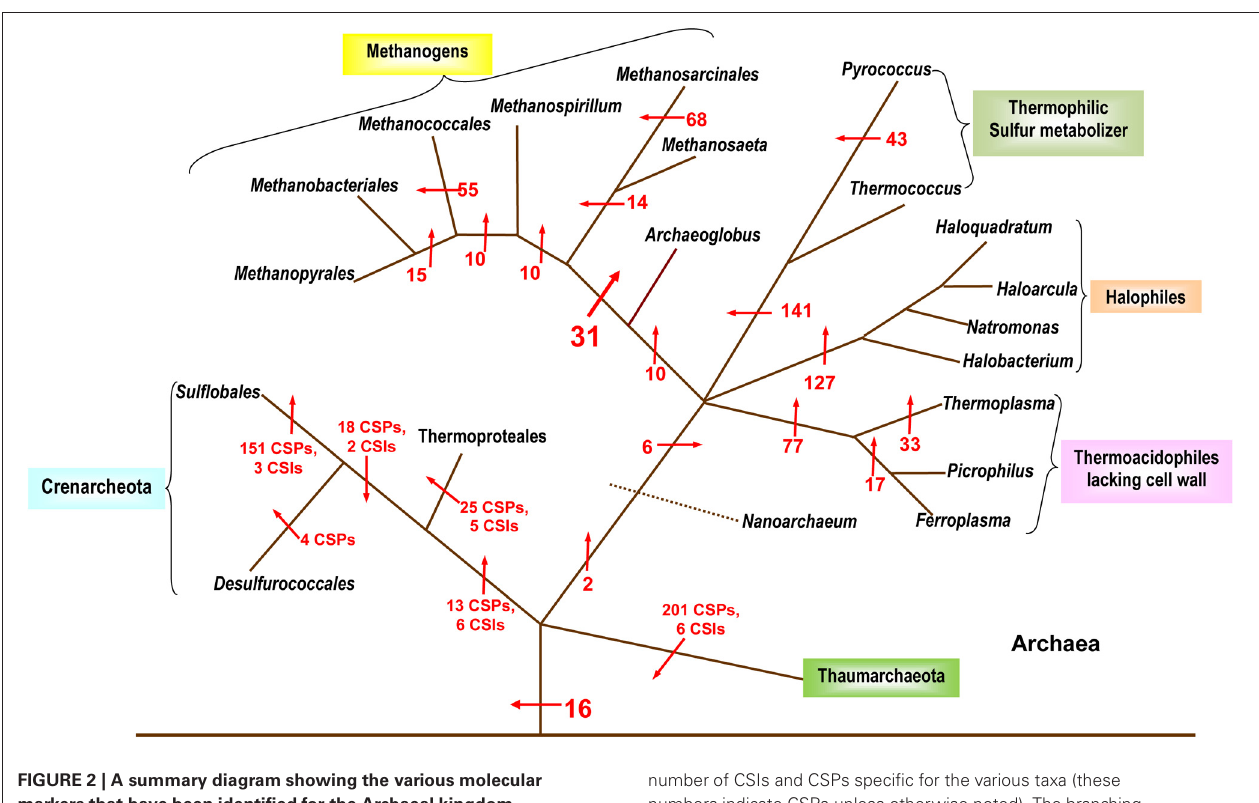
number of CSIs and CSPs specific for the various taxa (these numbers indicate CSPs unless otherwise noted). The branching pattern shown is based solely upon the distribution patterns of CSPs and CSIs. Modified from Gao and Gupta (2007) and Gupta and Shami